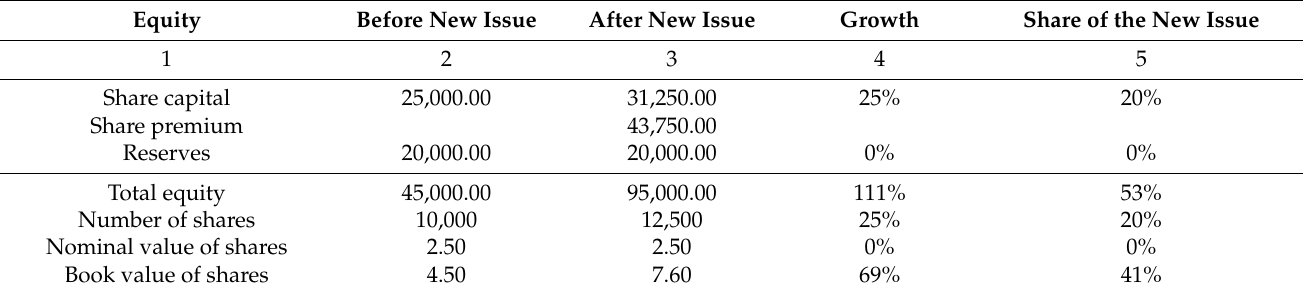
Table 1. Accounting consequences of the new share